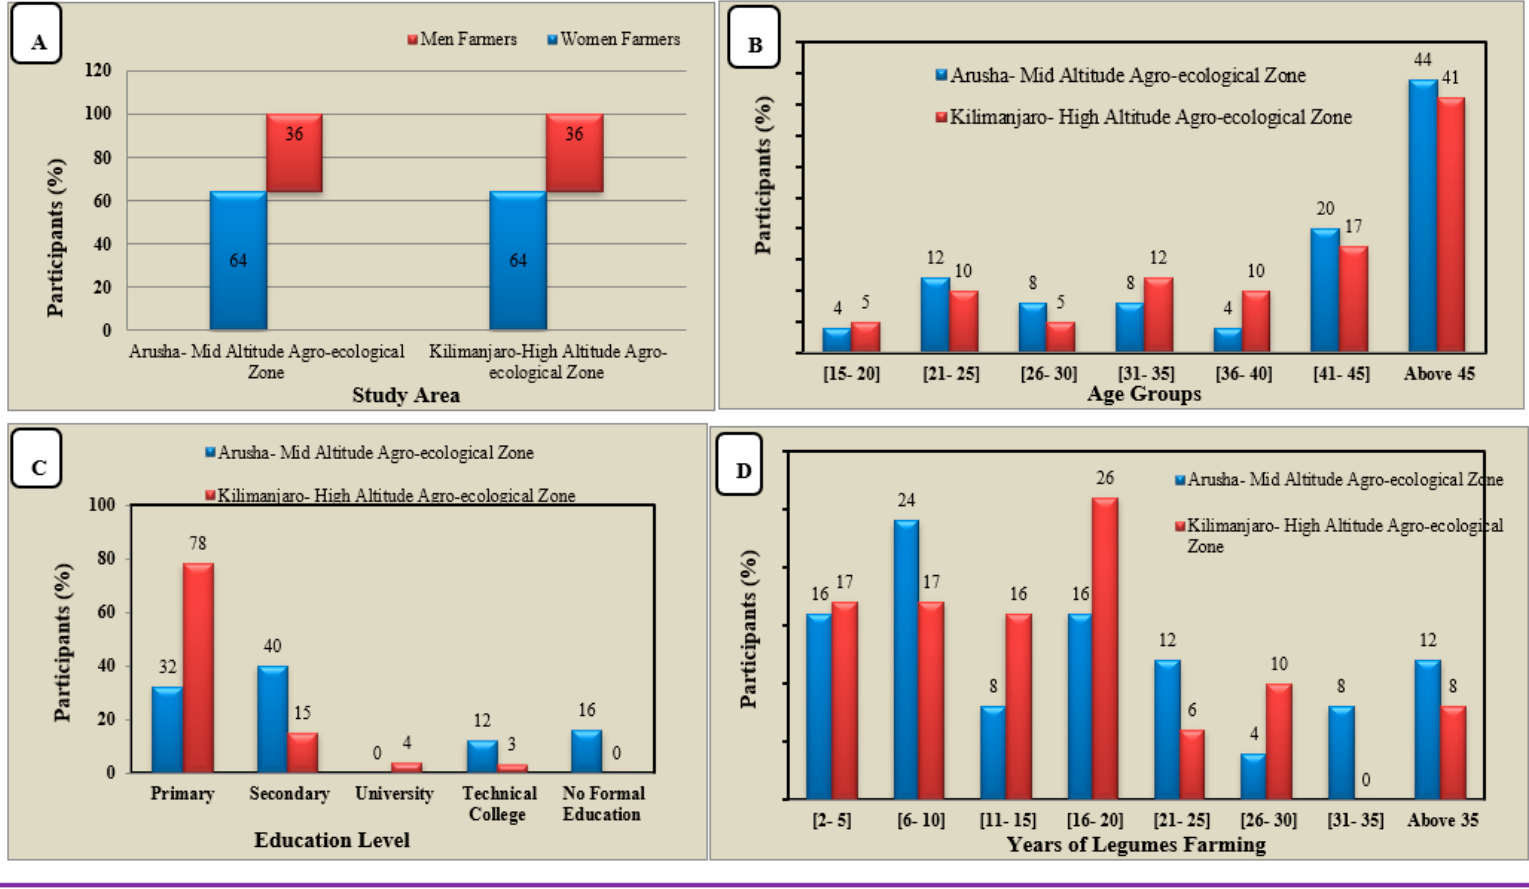
Figure 3. Sociodemographic characteristics of participants ( A ): participants’ gender per study area (%); ( B ): participants’ age groups; ( C ): participants’ education level; and ( D ): participants’ legumes farming experience.